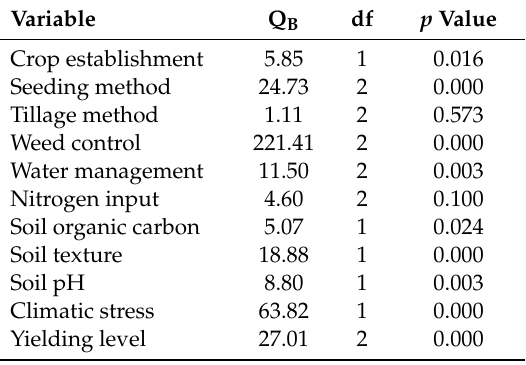
Table 2. Heterogeneity (Q B ) and p value for the direct seeding effect size on grain yield across different categorical variables.